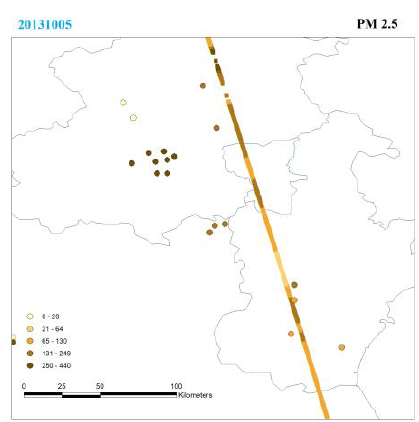
Figure 4. The estimates and ground observations of PM 2.5 mass